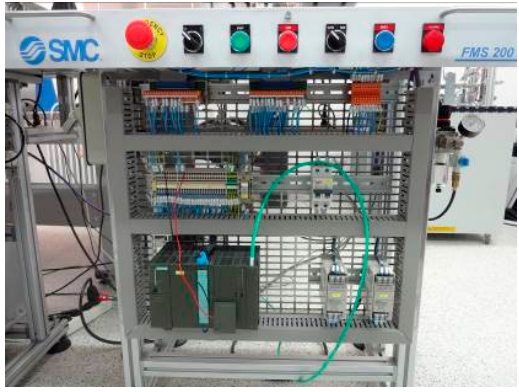
Figure 2. Front panel and keypad of one of the stations.